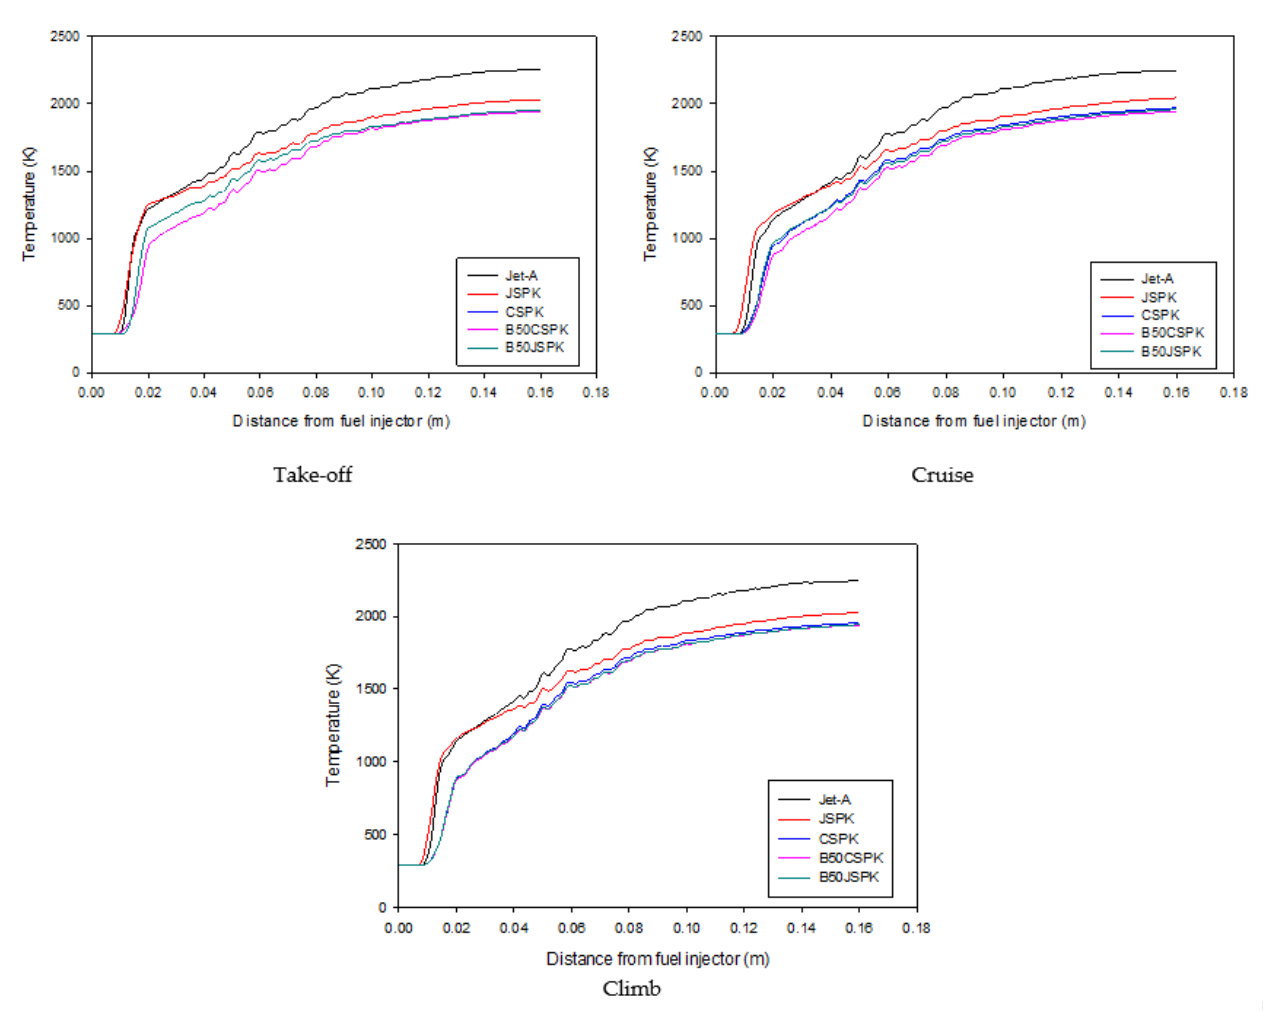
Figure 8. Temperature variation along the x -axis of the